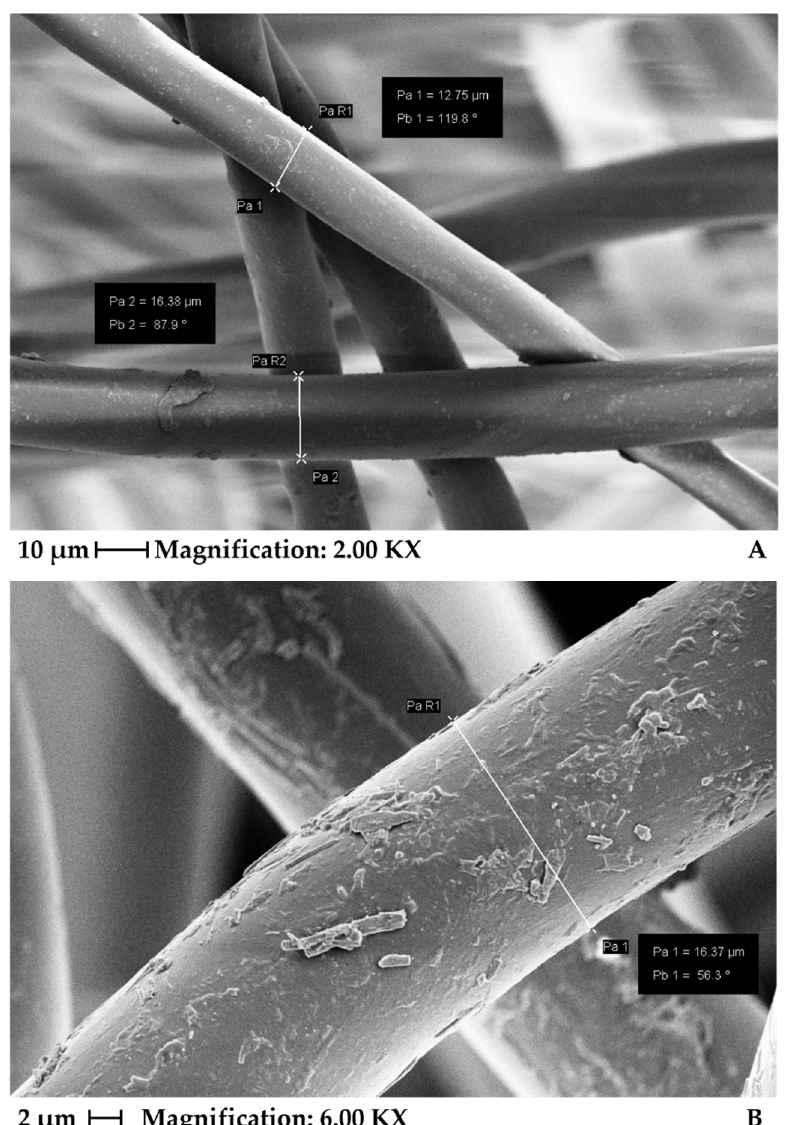
Figure 3. Scanning electronic microscopy indicating some fiber diameters of virgin PET ( A ) and PET 1000 h ( B ). 1000 h ( B